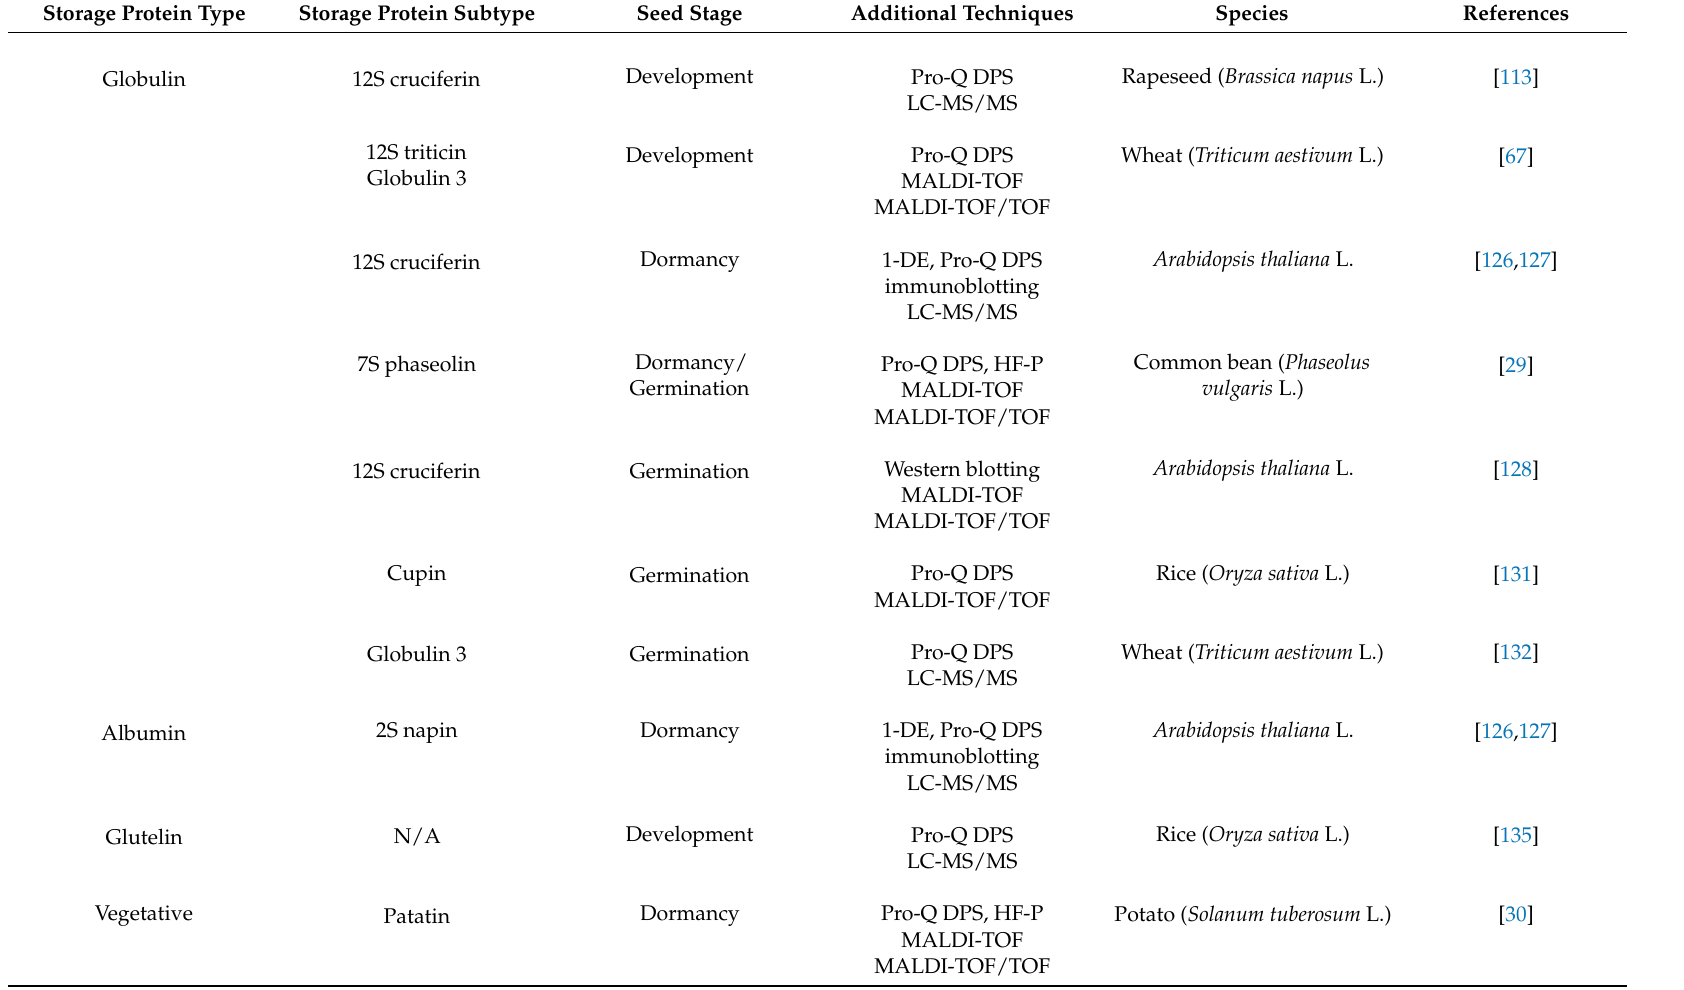
Table 2. List of 2-DE-based seed phosphoproteomic studies including storage